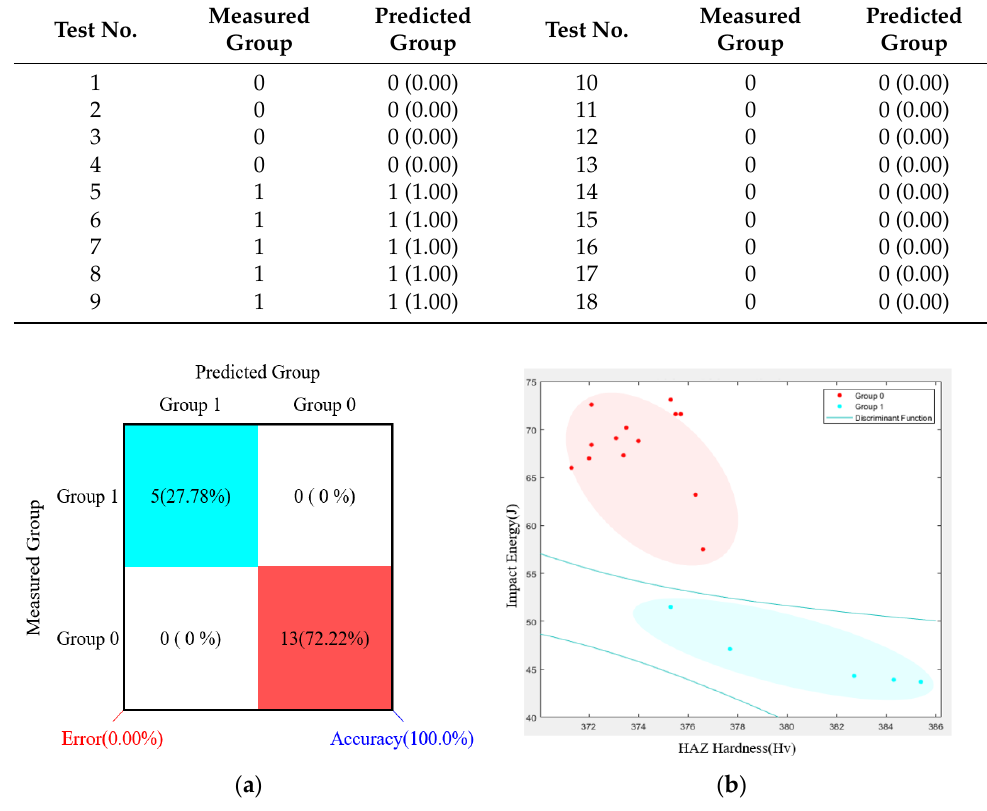
Figure 8. Brittle fracture behavior discrimination in fiber laser welding: ( a ) performance evaluation for SVM and ( b ) discrimination graph for SVM. Table 11. Results of group discrimination for brittle fracture behavior according to SVM.